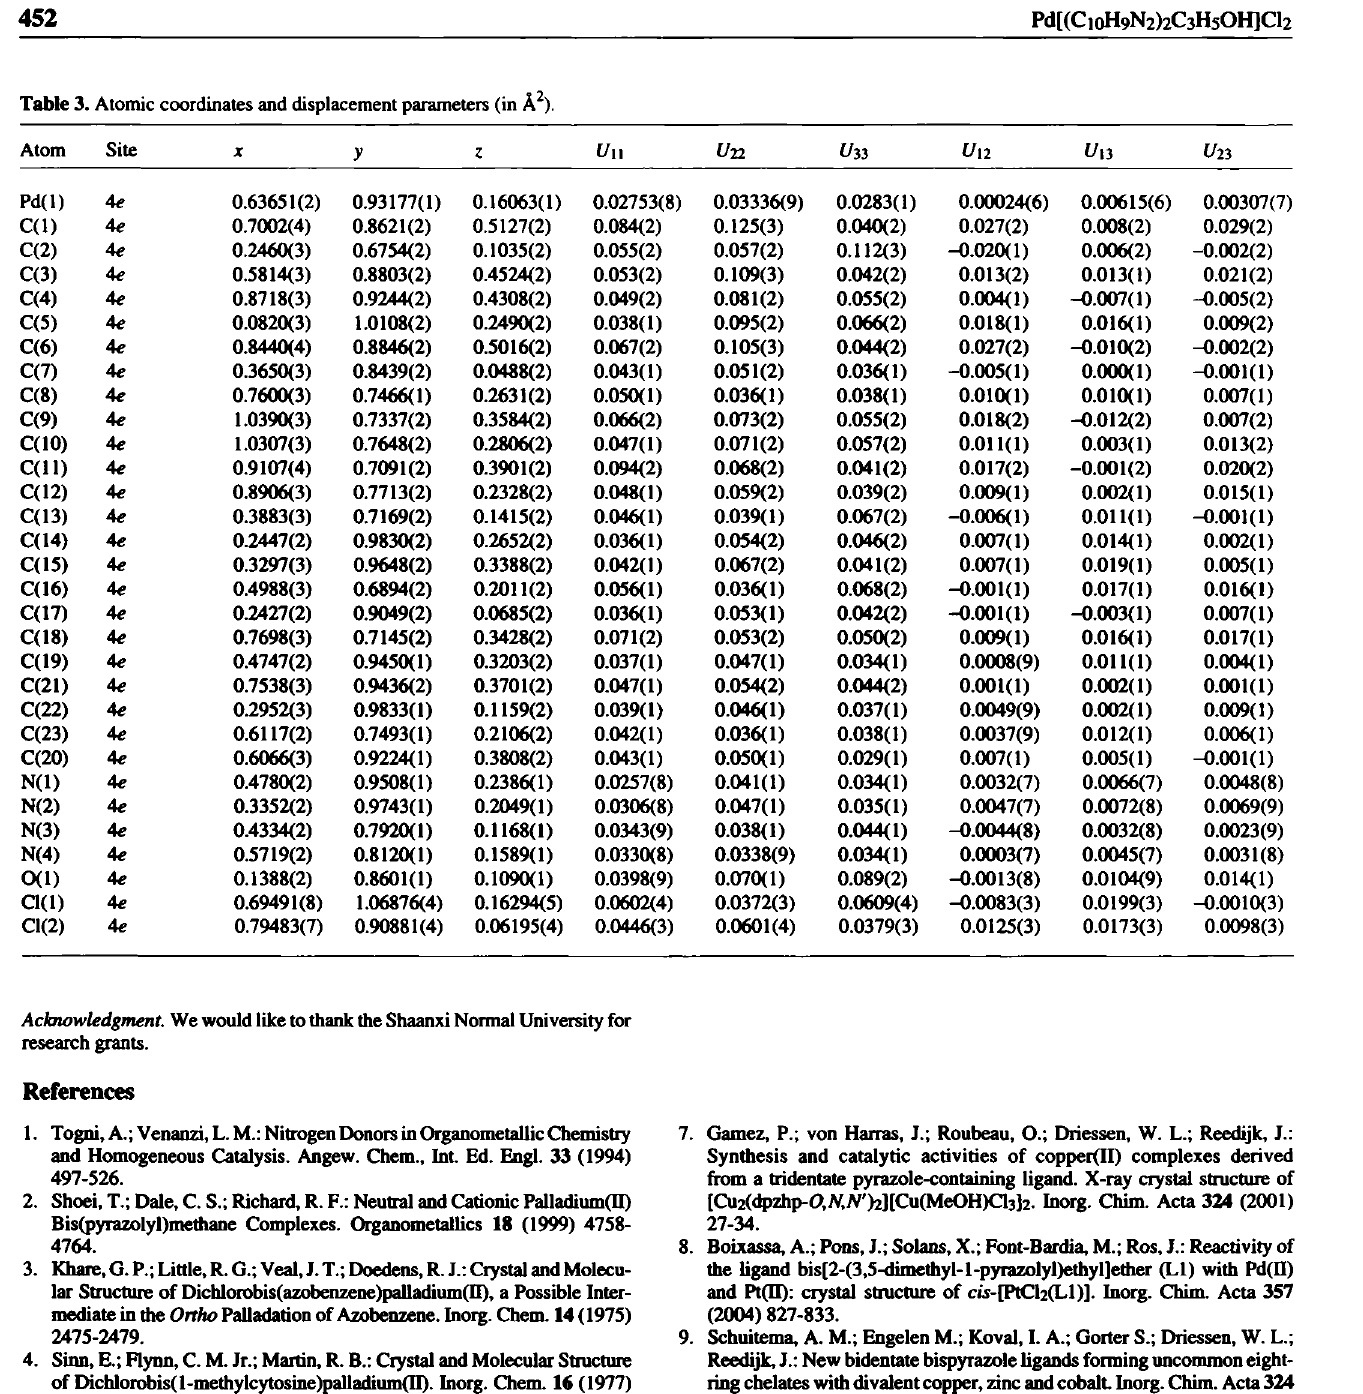
Table 3. Atomic coordinates and displacement parameters (in A 2